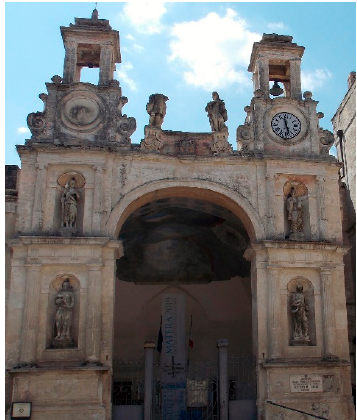
Figure 2. “Sedile” building.